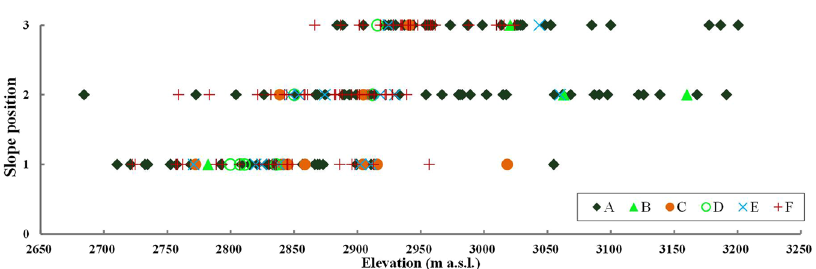
Figure 8. The distribution of all vegetated units within the potential distribution area of Qinghai spruce forests among the slope positions (1, 2 and 3 stands for lower slope, middle slope and upper slope, respectively). This map was generated using Microsoft Excel 2010